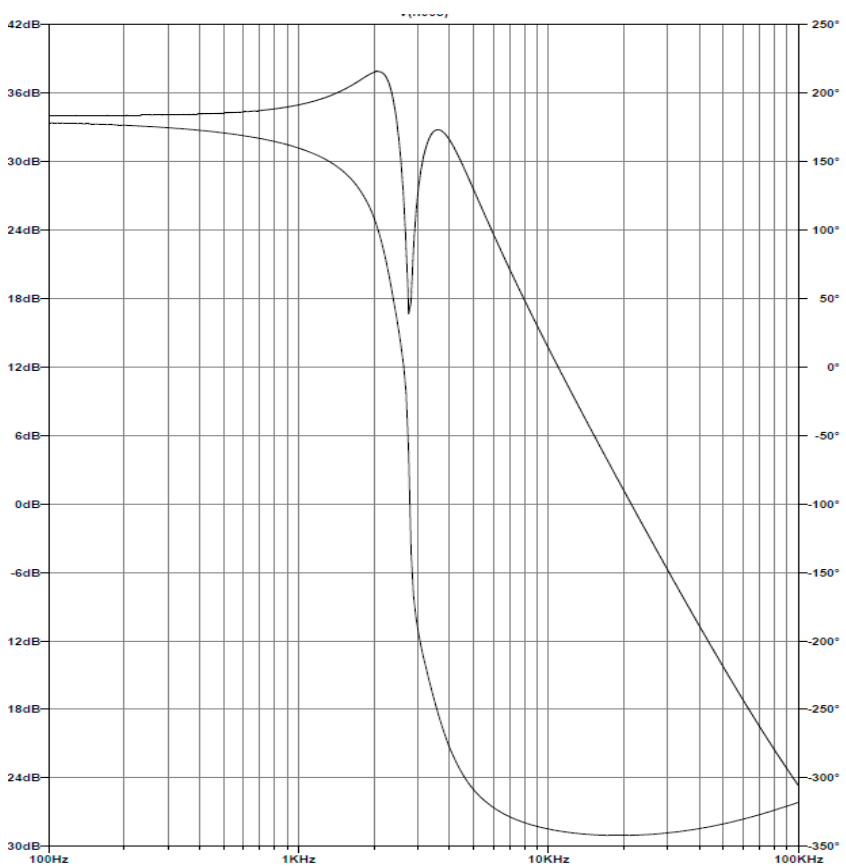
Figure 18. Circuit averaged model.